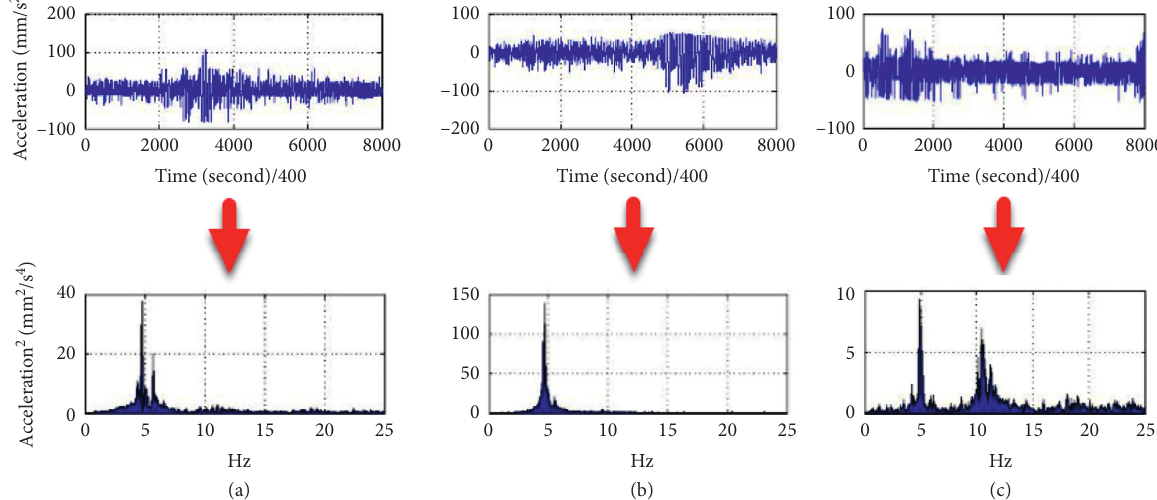
Figure 14: Some practical spectral types frequently appear in the measurement project of 38 bridges in district 2, district 9, and Thu Duc district.